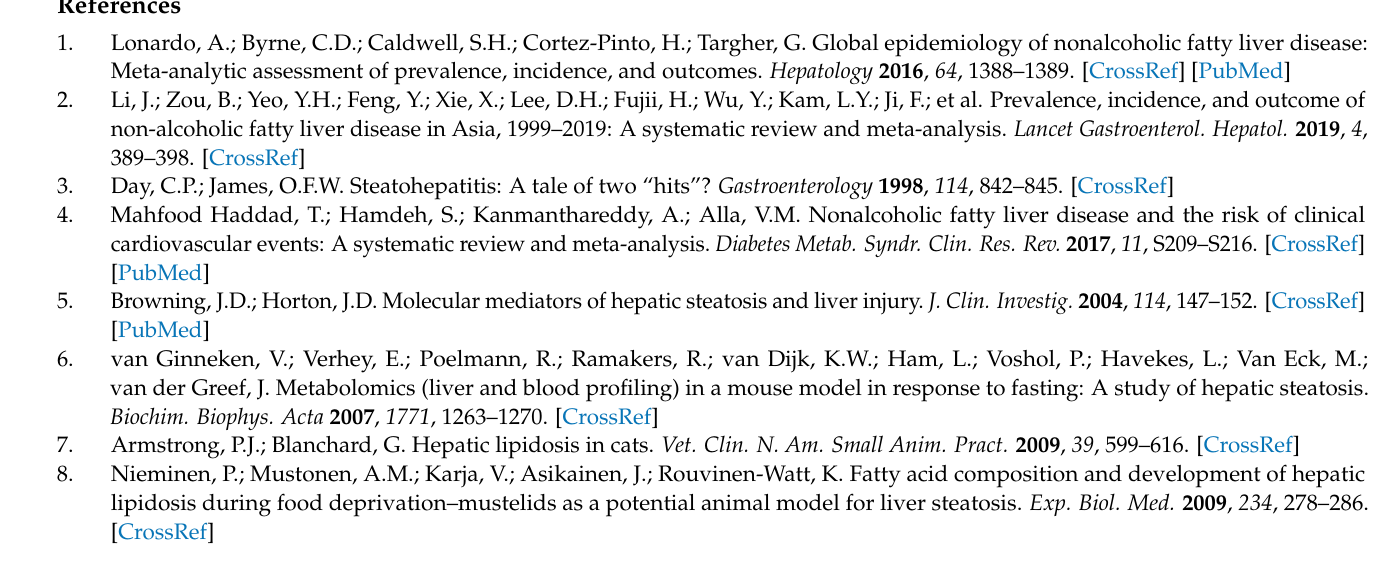
study. Table S2: Genes expressed only in the control and starved larvae, respectively. Table S3: Top 20 KEGG pathways with high representation of DEGs. Red and green indicate up- and down-regulated genes,